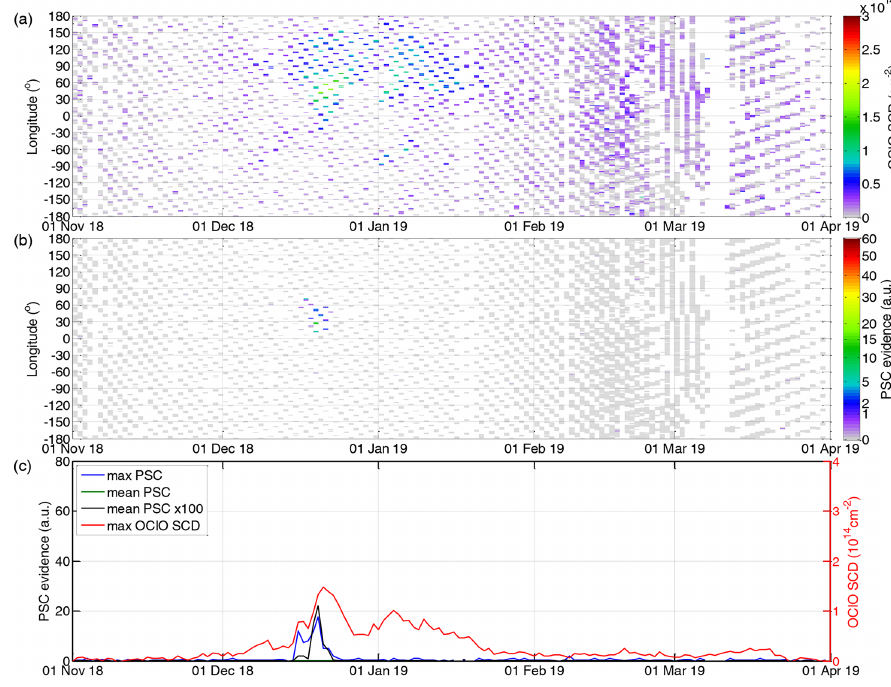
Figure 6. Same as Fig. 3 but for the Arctic winter 2018/19.